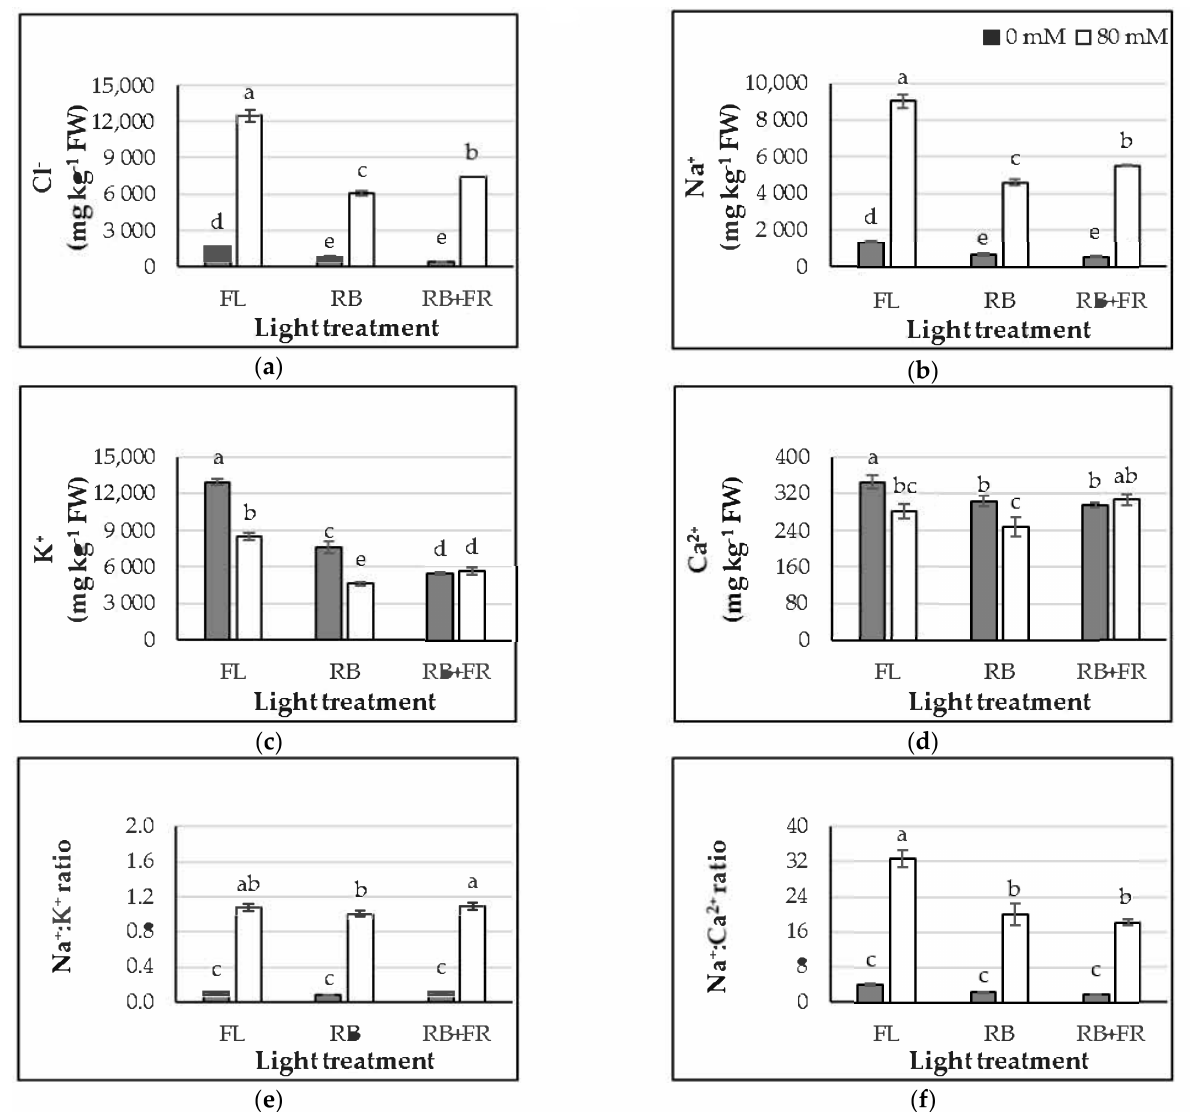
Figure 3. Effect of the different light (FL, RB and RB+FR) and salinity (0 and 80 mM NaCl) combinations on Cl − ( a ), Na + ( b ), K + ( c ), and Ca 2+ ( d ) content and Na + /K + ( e ) and Na + /Ca 2+ ( f ) ratios of purslane microgreens at harvest. Values are the mean ± SE (n = 9). Different letters indicate significant differences ( p ≤